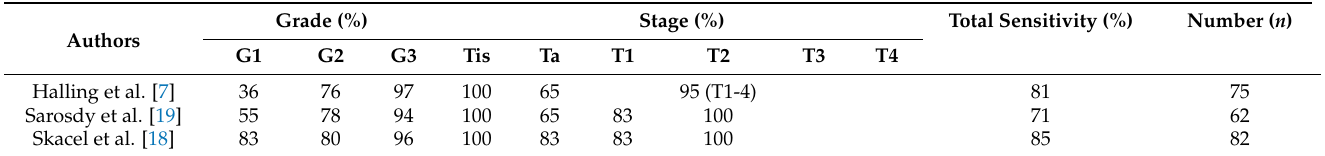
Table 1. Sensitivity of FISH in different grades and stages of bladder